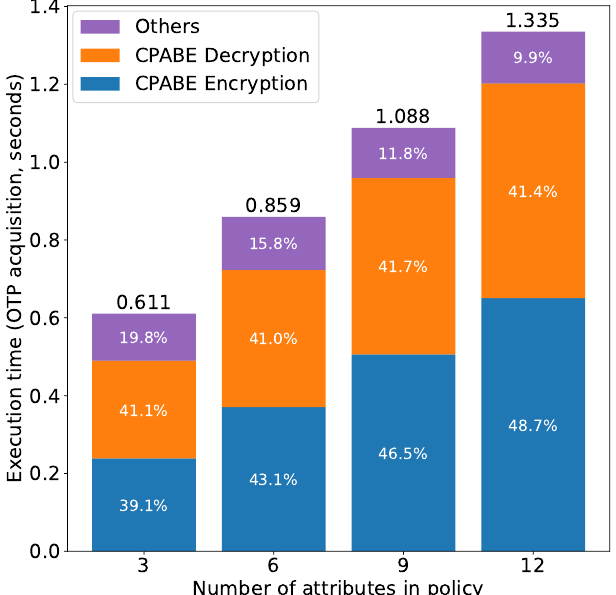
Figure 19. Access right verification time (Phase 1) vs. number of